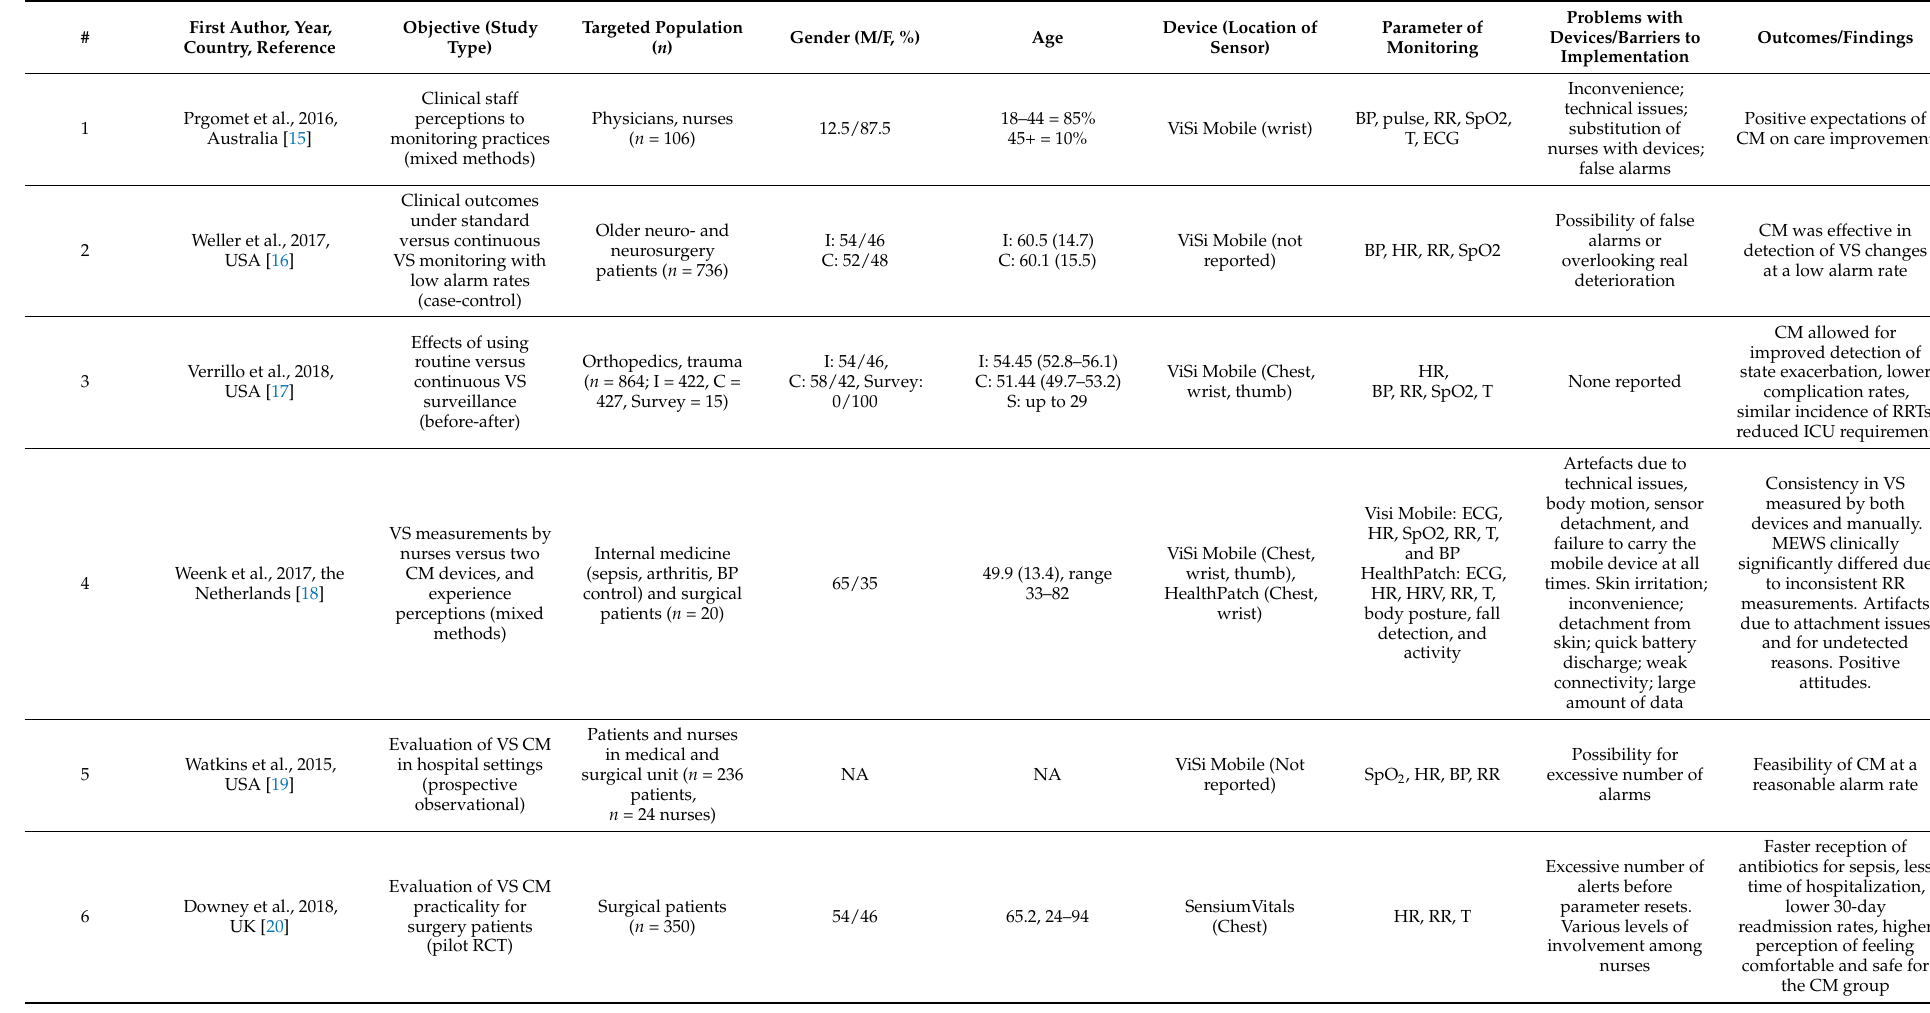
Table 1. Description of characteristics of included